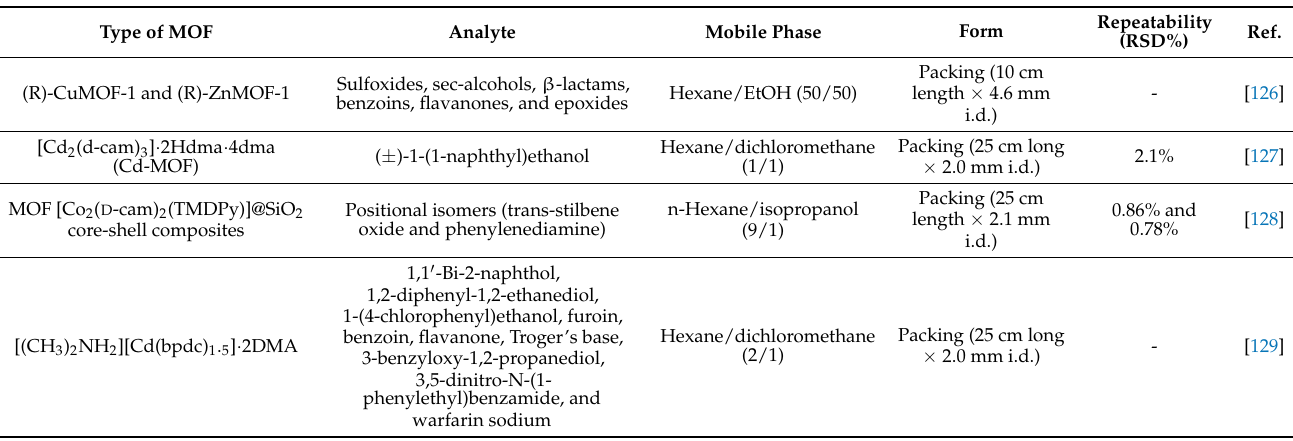
Figure 16. Crystal morphology tuning and post-synthetic modification of Co-MOF-74 for enantioselective HPLC separation of eight drug racemates. Reprinted (adapted) with permission from [125]. Table 2. MOF-based composites used as chiral stationary phases for HPLC.